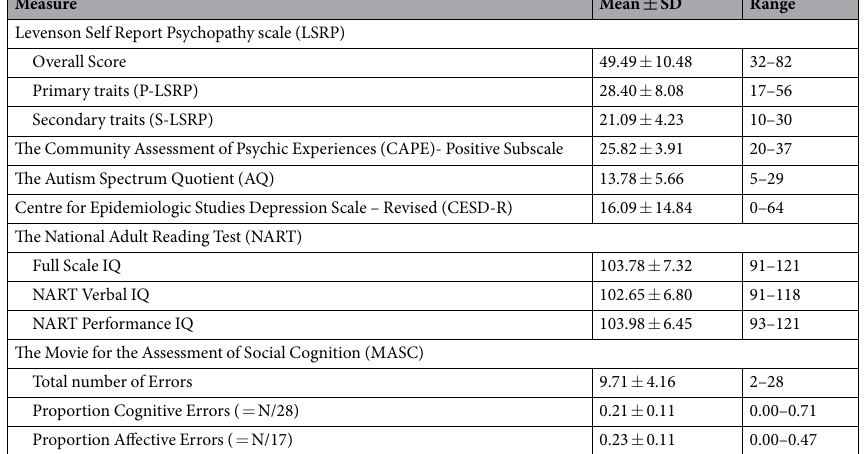
Table 1. Mean ± SD for all self-report questionnaire measures, the National Adult Reading Test, and the number of errors on the Movie for the Assessment of Social Cognition (N =